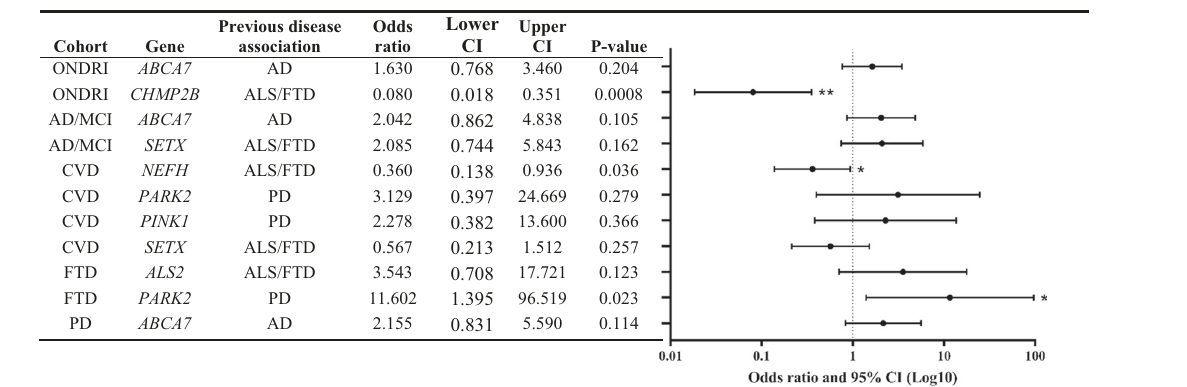
Table 3. Gene-based rare variant association analyses using Firth logistic regression comparing rare variant enrichment in the ONDRI cohorts compared to the control cohort, in genes identi fi ed as having differing enrichment by